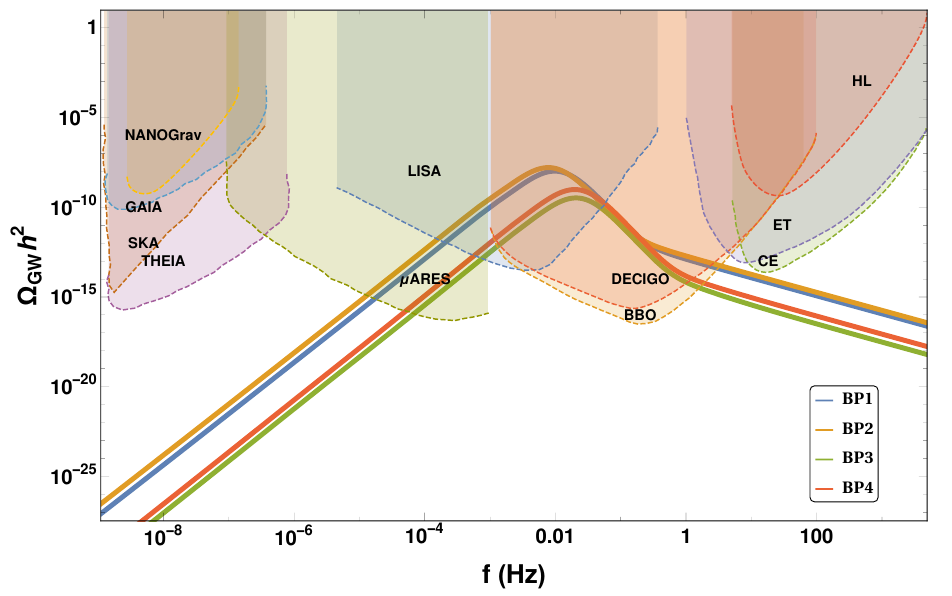
Figure 5 . Gravitational wave spectrum from FOPT in the hybrid model for four different bench- mark points given in table 3. Different coloured curves show the sensitivities from GW search experiments like LISA, BBO, DECIGO, HL (aLIGO), ET, CE, NANOGrav, SKA, GAIA, THEIA and µ